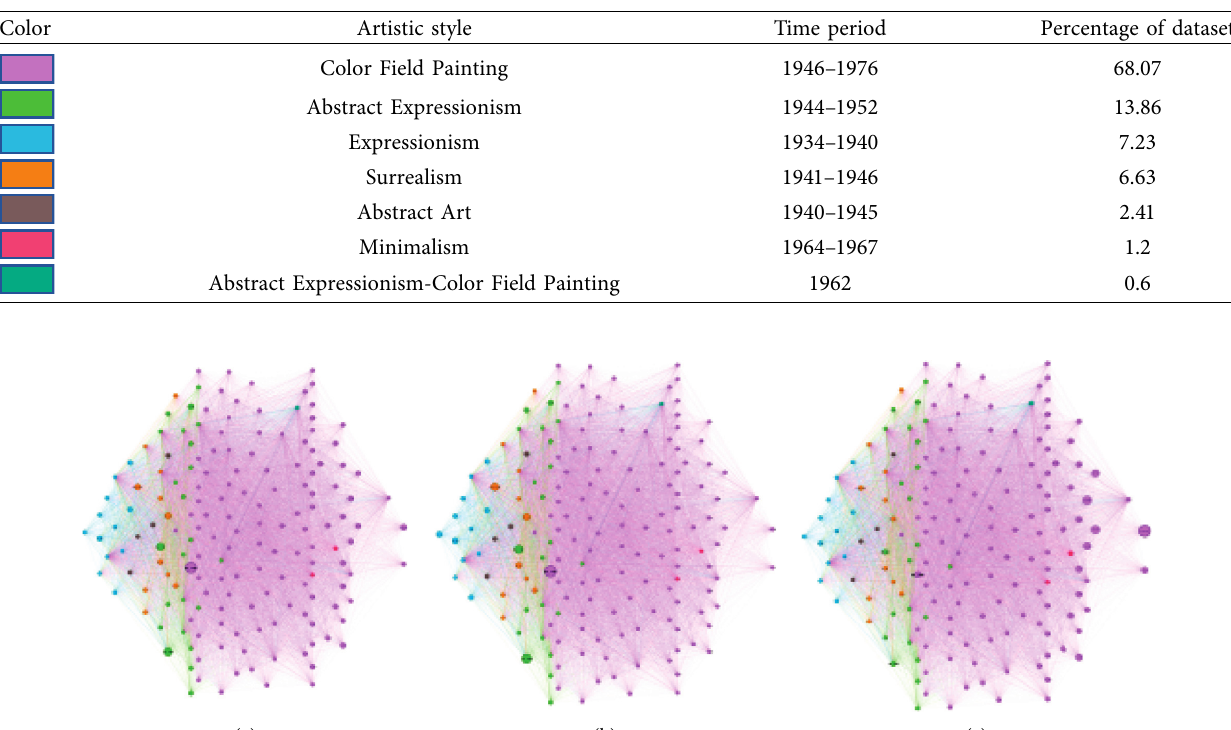
Table 3: Color style conventions—dataset information.